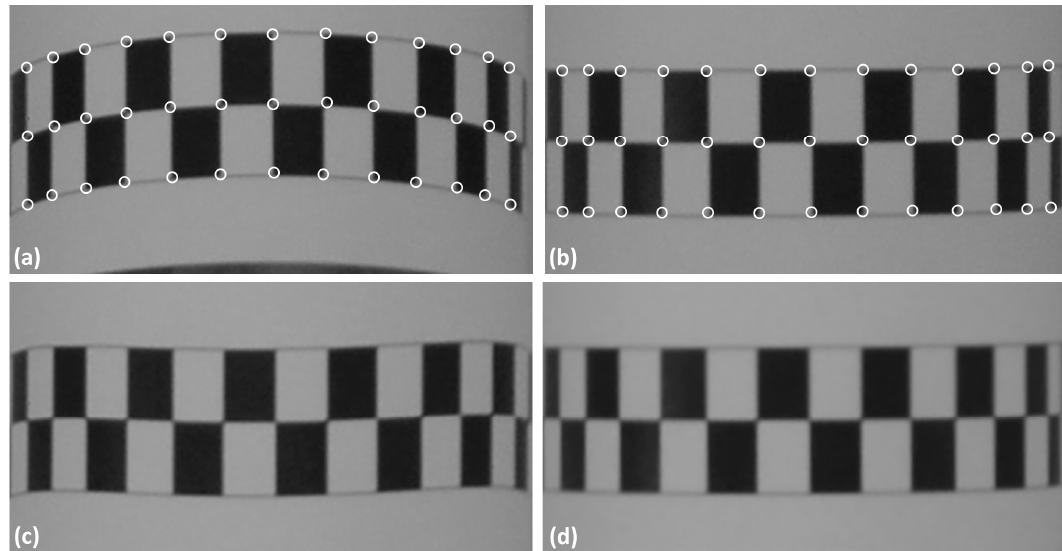
Figure 5. ( a , b ) are the resulting effects due to the camera viewpoints shown in Figure 4b,c, and the corners (white circles) automatically extracted from the corresponding image patches are also shown.